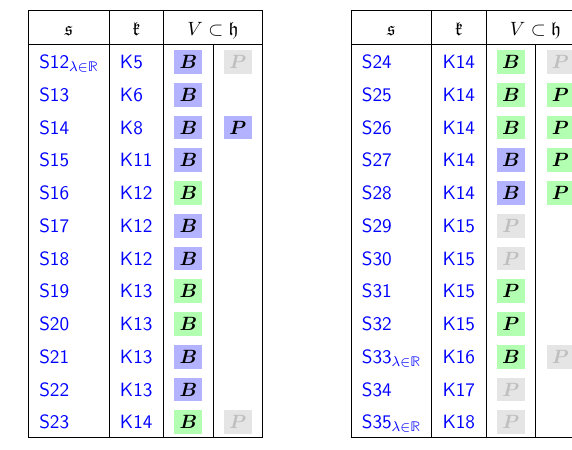
Table 12 . Summary of super Lie